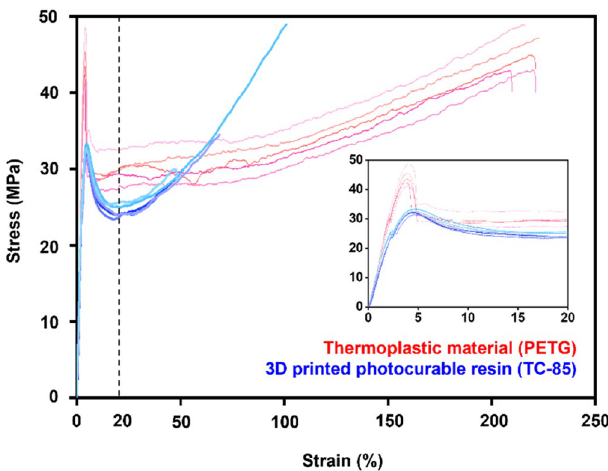
Figure 1. Stress–strain curve of TC-85 and PETG; The small stress–strain curve is an enlargement of the initial range (dash line).